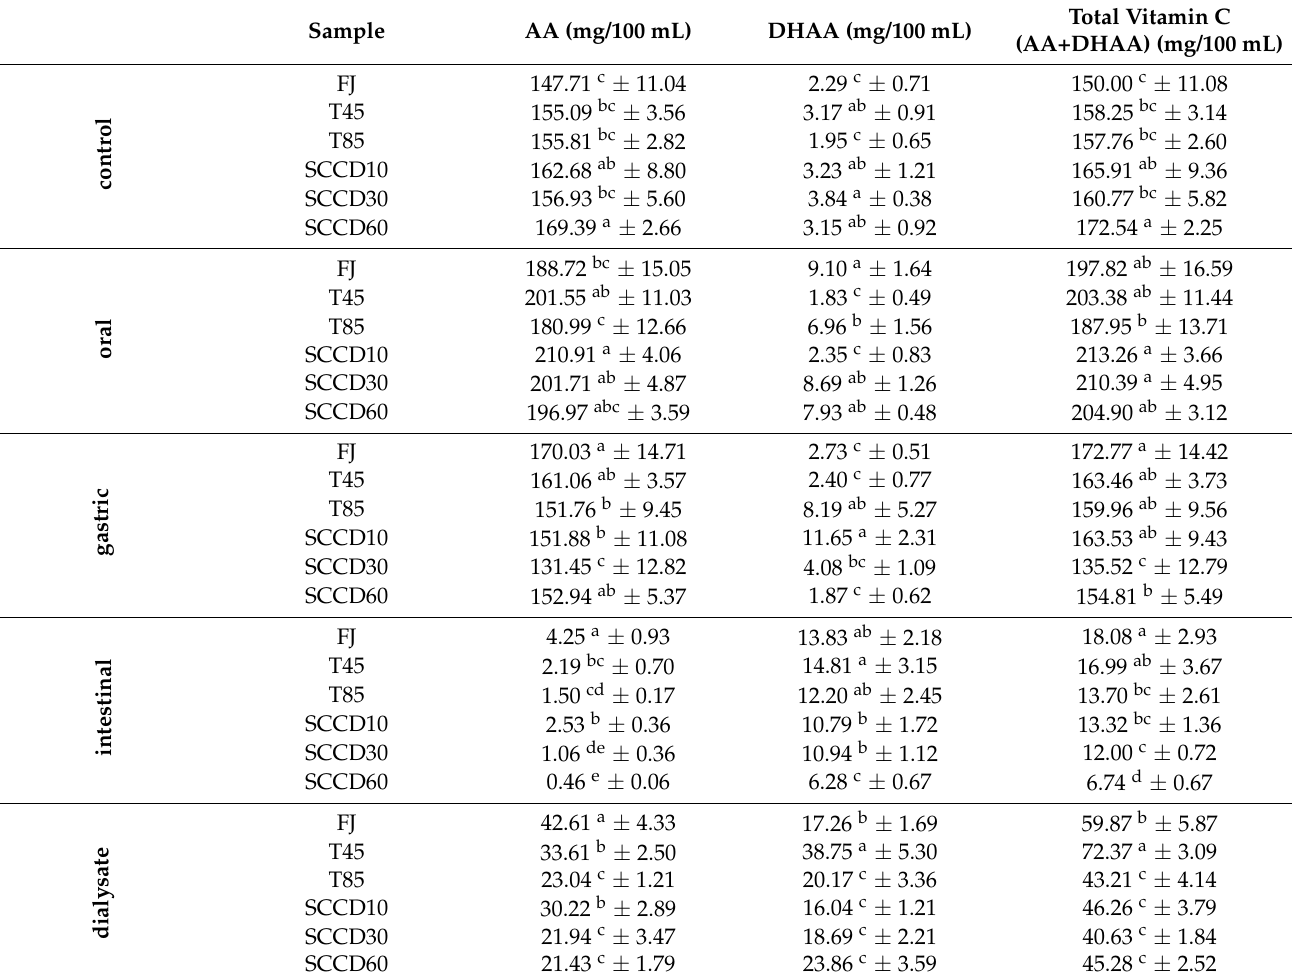
Table 1. L -ascorbic acid (AA), L -dehydroascorbic acid (DHAA) and total vitamin C content at each stage of the digestion of blackcurrant